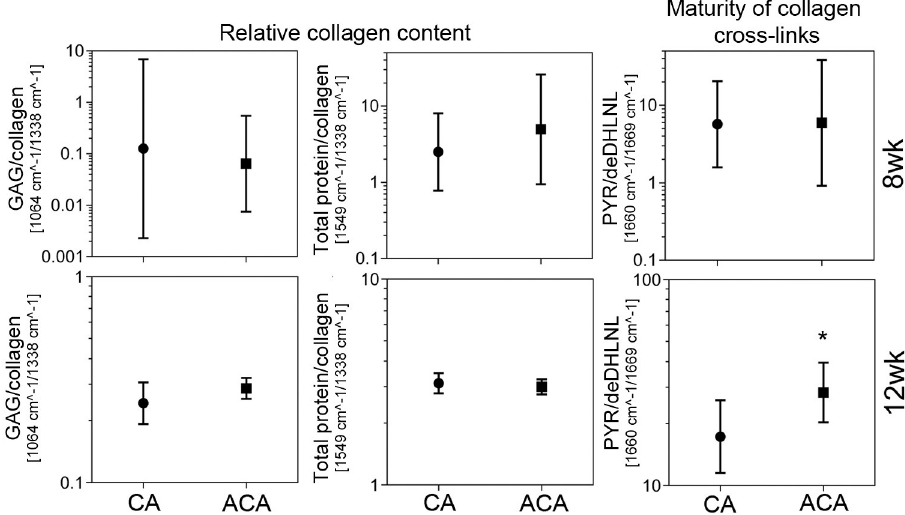
Fig 7. A graphic representation of the FTIR-based assays of the relative amount of collagen and the maturity of collagen cross-links in the scar tissue formed in the OCDs of the CA-treated and the ACA-treated rabbits. Results for the 8wk and the 12wk groups are presented. The graphs present GMs with 95% confidence intervals. Asterisks indicate groups with statistically significant differences of means. The graph shows the relative collagen content calculated as the GAG/collagen and the total protein/collagen ratios. Hence, the smaller the ratios, the higher relative collagen content. The ratios were calculated based on the areas of the spectral peak corresponding to the sulphated GAGs (centered around 1064 cm -1 ) and the spectral peak corresponding to collagen (centered around 1338 cm -1 ). To corroborate these measurements, the relative amount of collagen was also calculated based on the ratios of the spectral peak corresponding to the total proteins, represented by the amide II peak (centered around 1549 cm -1 ) and the spectral peak corresponding to collagen. The maturity of collagen cross-links was expressed as the ratio of the area of the spectral peak corresponding to the mature trivalent PYR cross-link (centered around 1660 cm -1 ) and immature divalent deDHLNL cross-link (centered around 1690 cm -1 ). Thus, the higher the PYR/deDHLNL ratio, the more mature the collagen cross-links. See also S1 Table in S1 File.